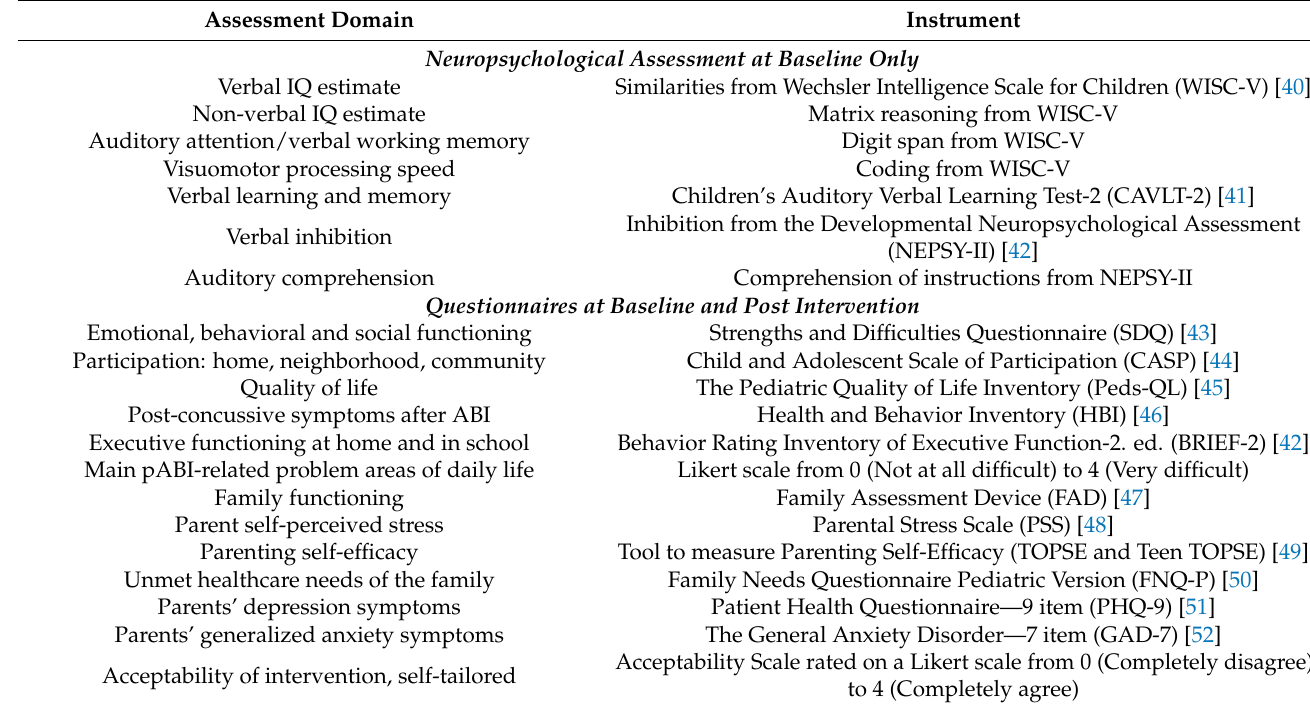
Table 1. Measures included in the feasibility study.